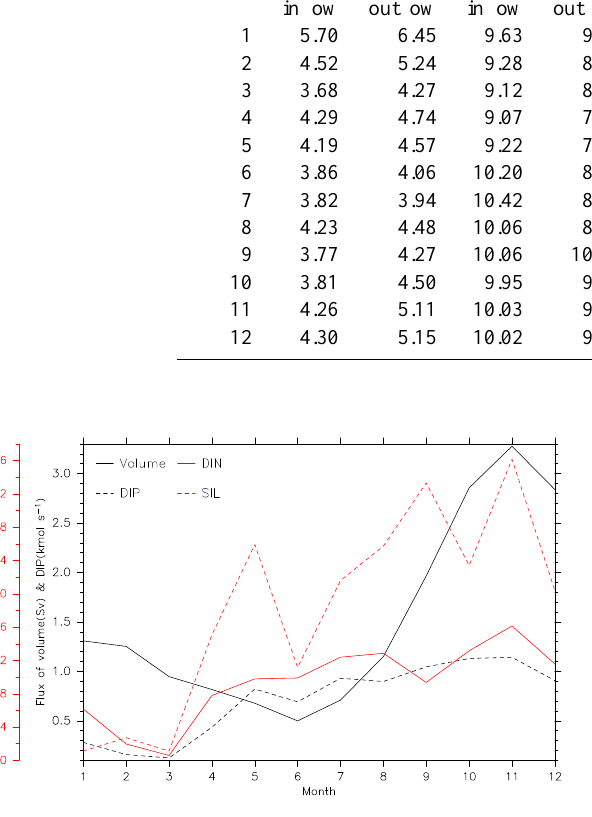
Table 2. Monthly mean nitrate concentration and volume transport of inflow and outflow across the 200-m isobath at the areas northeast of Taiwan(NoT) and southwest of Kyushu(SoK). Positive values denote onshore transport. mean nitrate concentration (mmolm − 3 ) volume transport (Sv) Month NoT SoK NoT SoK inflow outflow inflow outflow inflow outflow inflow outflow 1